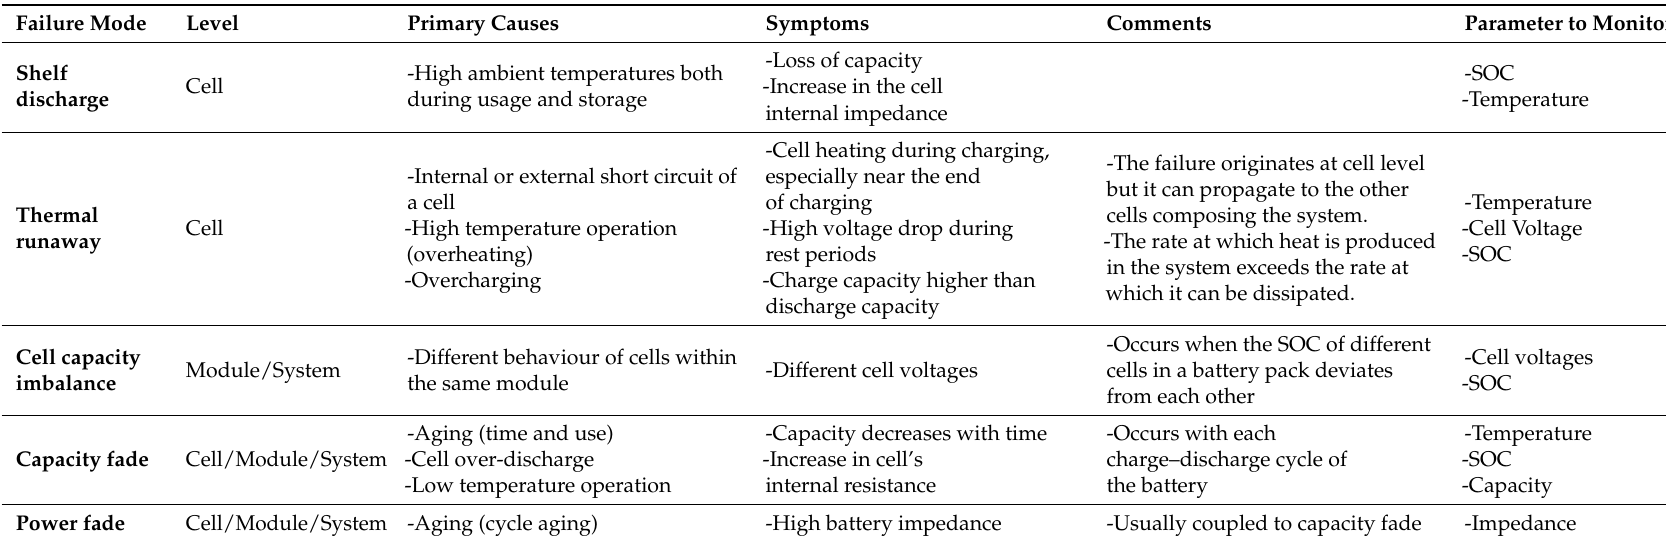
Table 1. Summary of battery failure